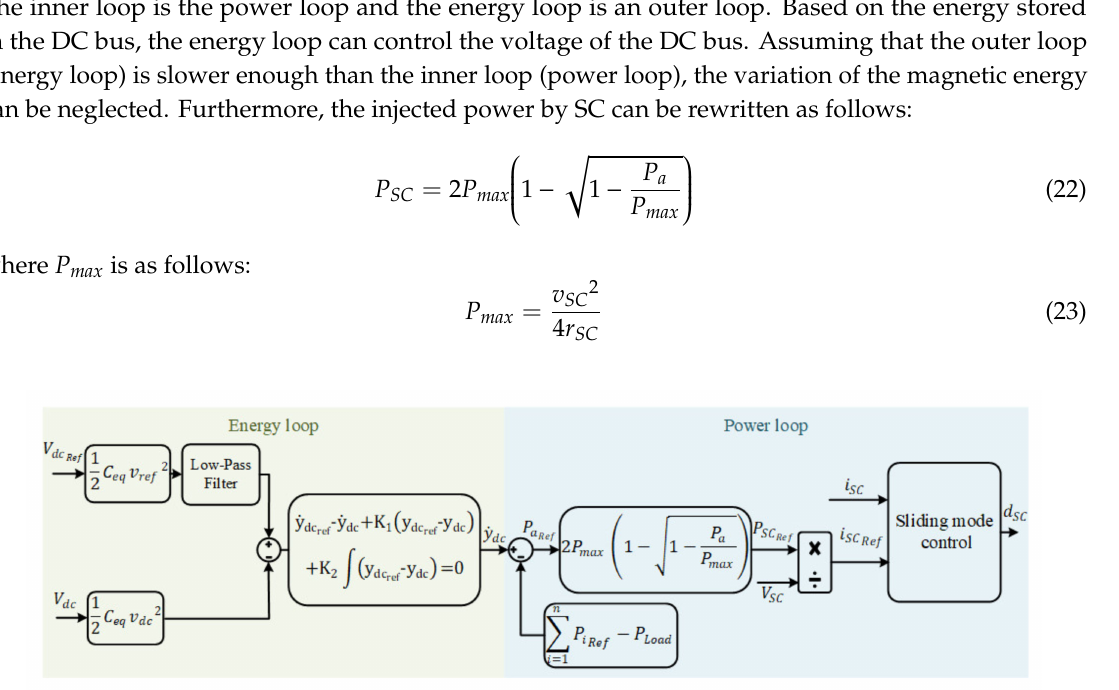
Figure 8. Schematic diagram of the voltage